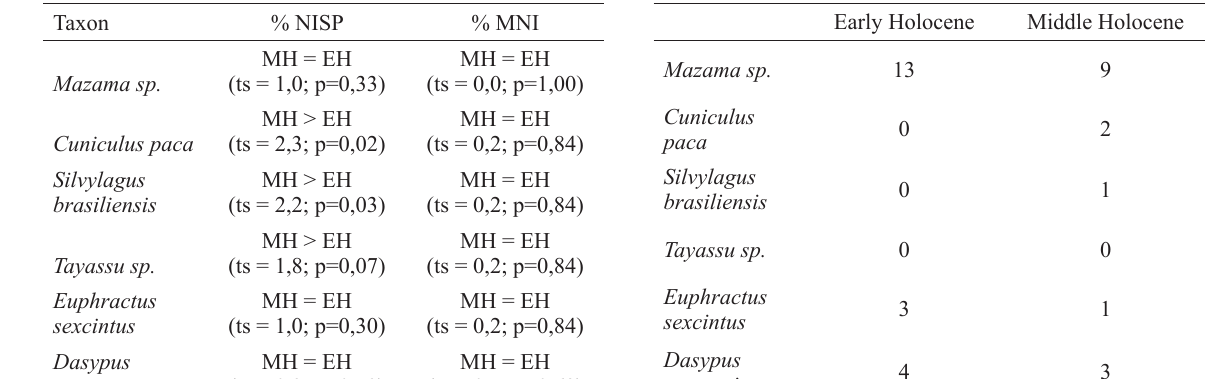
Absolute abundance of complete skeletal elements of taxa classified as genus or species for the Early and Middle Holocene levels, after Perez